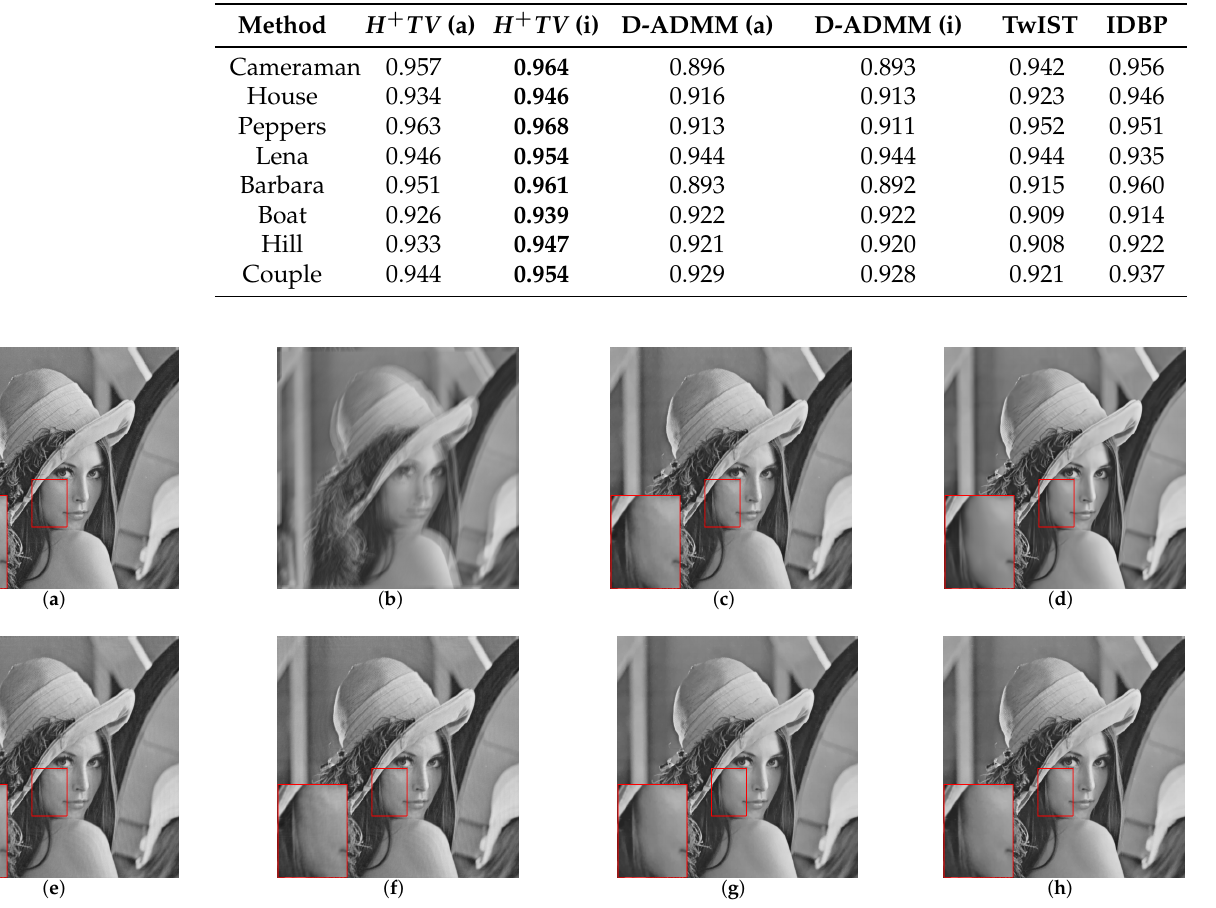
Table 2. Comparison of SSIM values of each method in eight plots.